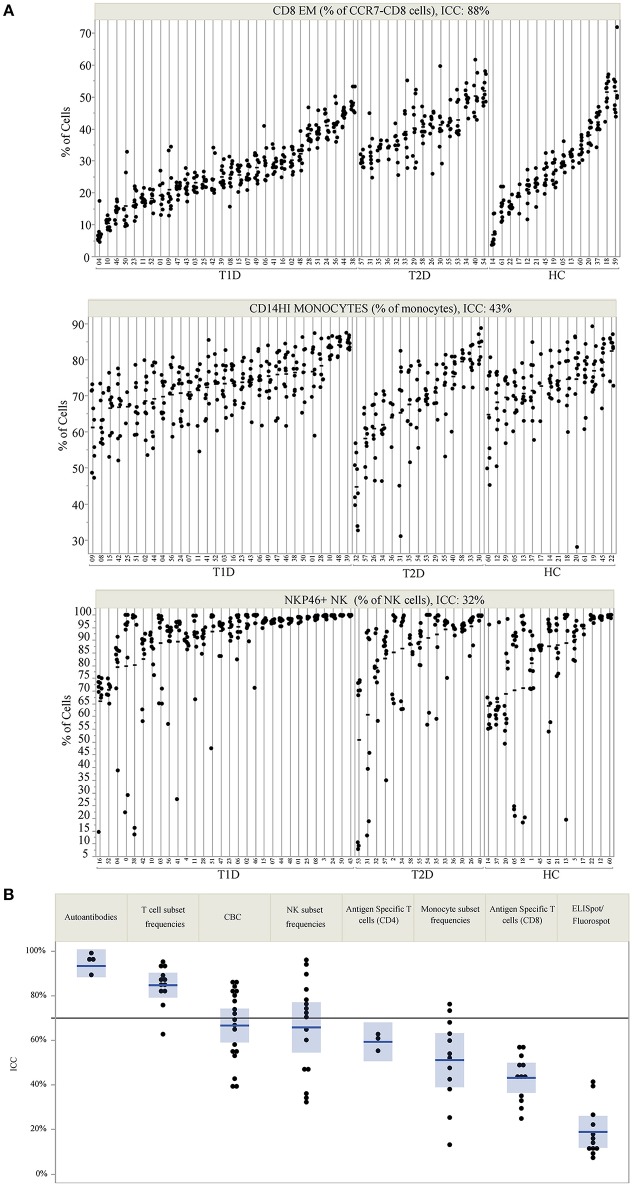
ICC identifies markers that are stable within an individual but vary between individuals. (A) Repeated assessments of CD8 EM, CD14HI Monocytes, and NKP46+ NK cells are shown for each subject. Subject IDs are listed on the X-axis, are divided by subject type, and are rank-ordered by the mean value of each immune marker within each subject type. The clustering of values by participant ID illustrates the relative amount of between- and within-subject variation. The total variation that is between subjects is quantified by the ICC, which is 88% for CD8 EM, 43% for CD14HI Monocytes, and 32% for NKP46+ NK cells. (B) The ICC for all measured markers is displayed by immune marker category. The reference line at 70% marks the threshold used to select markers for PLS modeling. ICC values are listed by marker in Table 2.